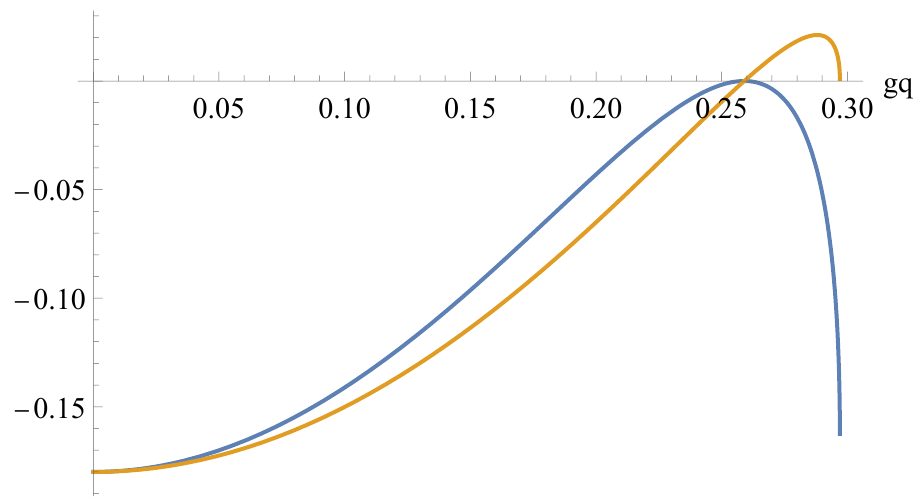
Figure 6 . Comparison of the leading overall forces for the scattering of two point-like states approximating far-away black holes in blue, and one Kaluza-Klein-like state and one similar to the black hole in yellow. Here, α = 0 . 7 , and m = 0 . 3 in Planck